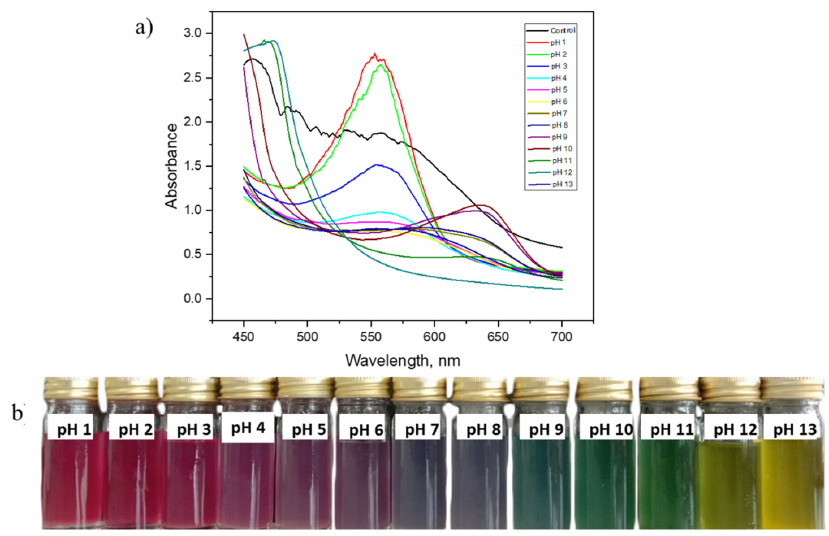
Figure 1. ( a ) UV–vis spectra of indicator solutions in a series of pH buffers and ( b ) changes of RCA solution in the buffer solutions .